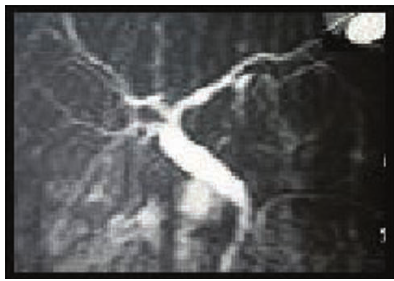
Figure 2. Postoperative MRI view of the